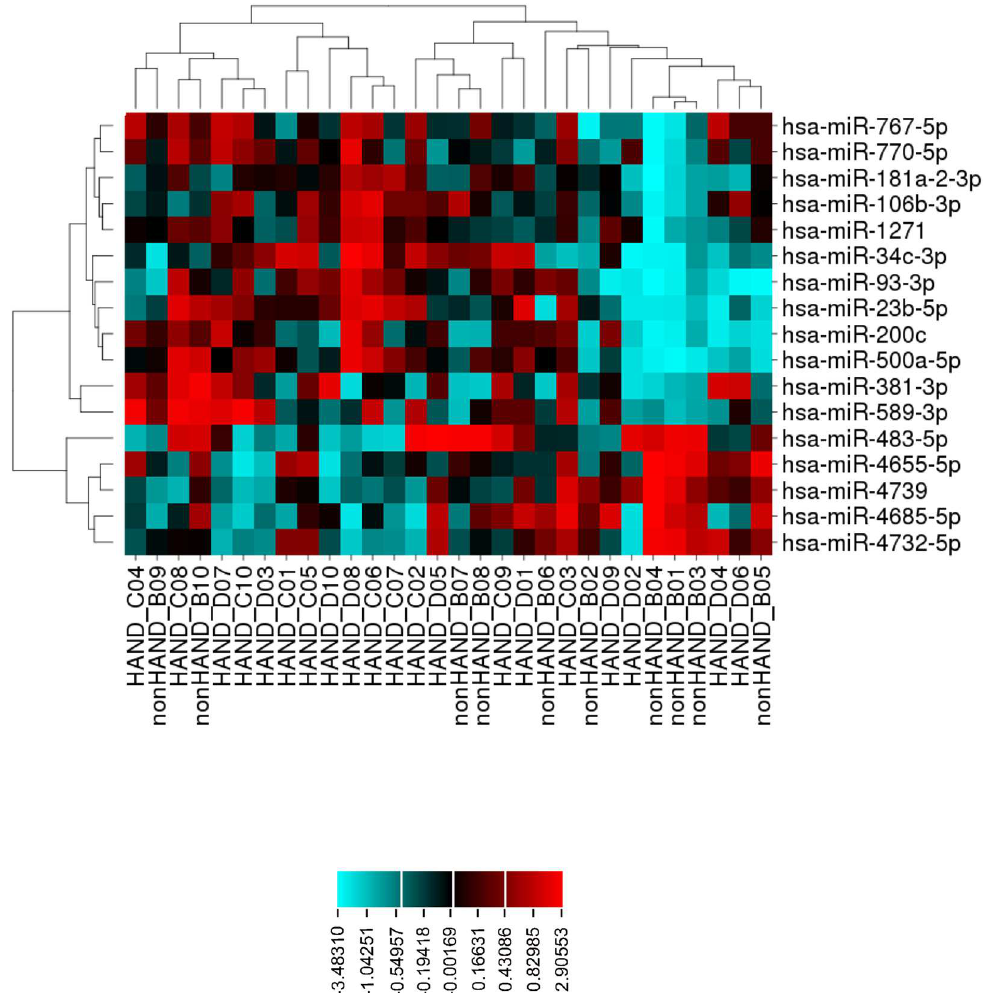
Fig 1. Distinct miRNA profile in brains of HAND patients. 12 up-regulated (red) and 5 down-regulated(blue) miRNAs were identifiedin brains of HAND (n = 20) comparedto nonHAND(n = 10) patients basedon Gene Spring RMA normalization method. miRNAs that were down-regulated(bottom right) cluster togetherwhile up- regulatedmiRNAs (top right) form anothercluster. Also, those from HAND and non-HANDpatient samples form